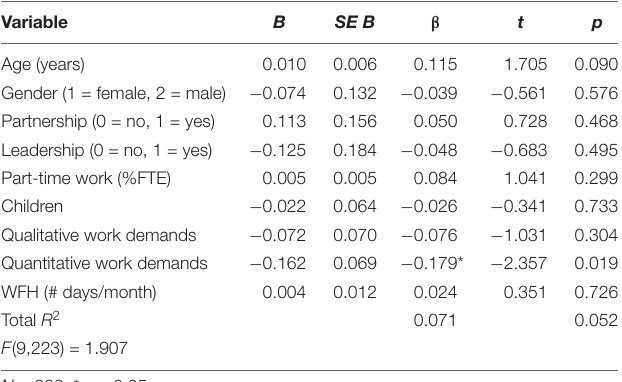
TABLE 5 | Multiple linear regression analysis for work from home (WFH) predicting improved work-life balance during COVID-19 pandemic (H4).